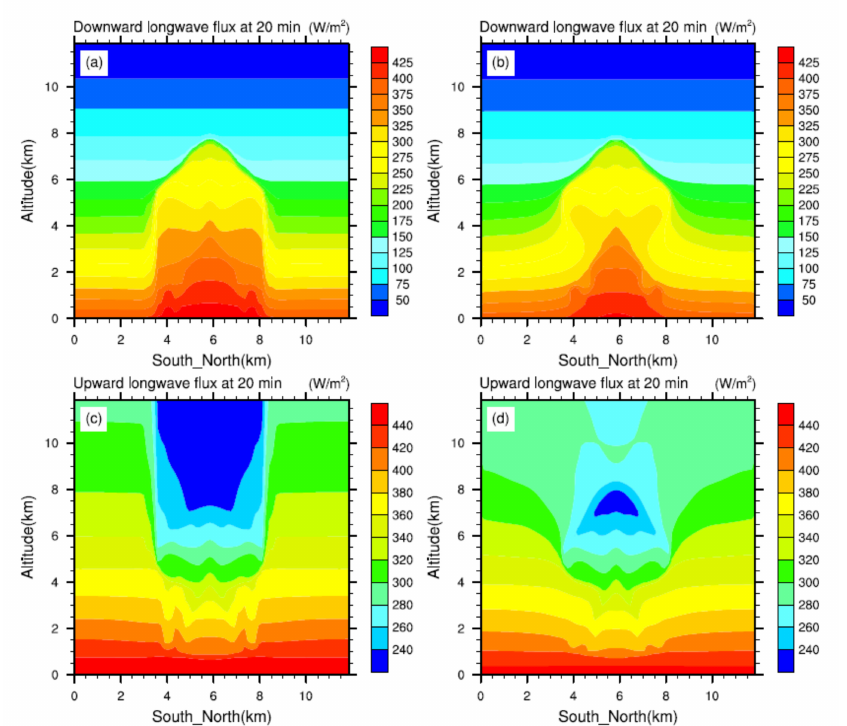
Figure 5. Downward and Upward longwave radiation flux in the 1D radiation case ( a , c ) and the 3D radiation case ( b , d